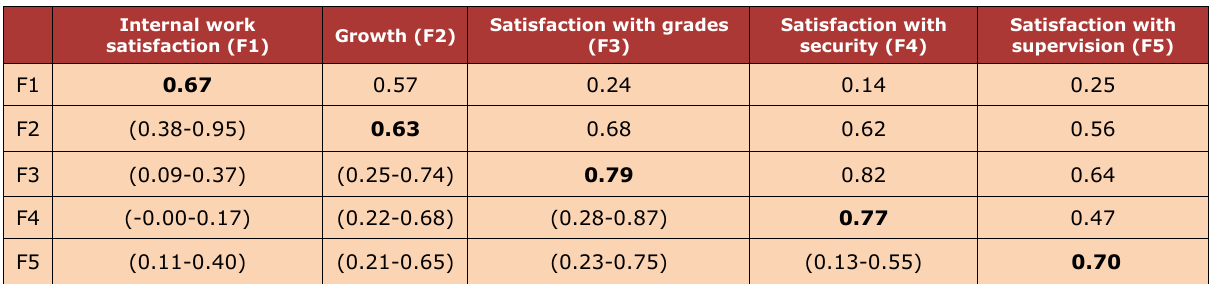
Table 11. Discriminant